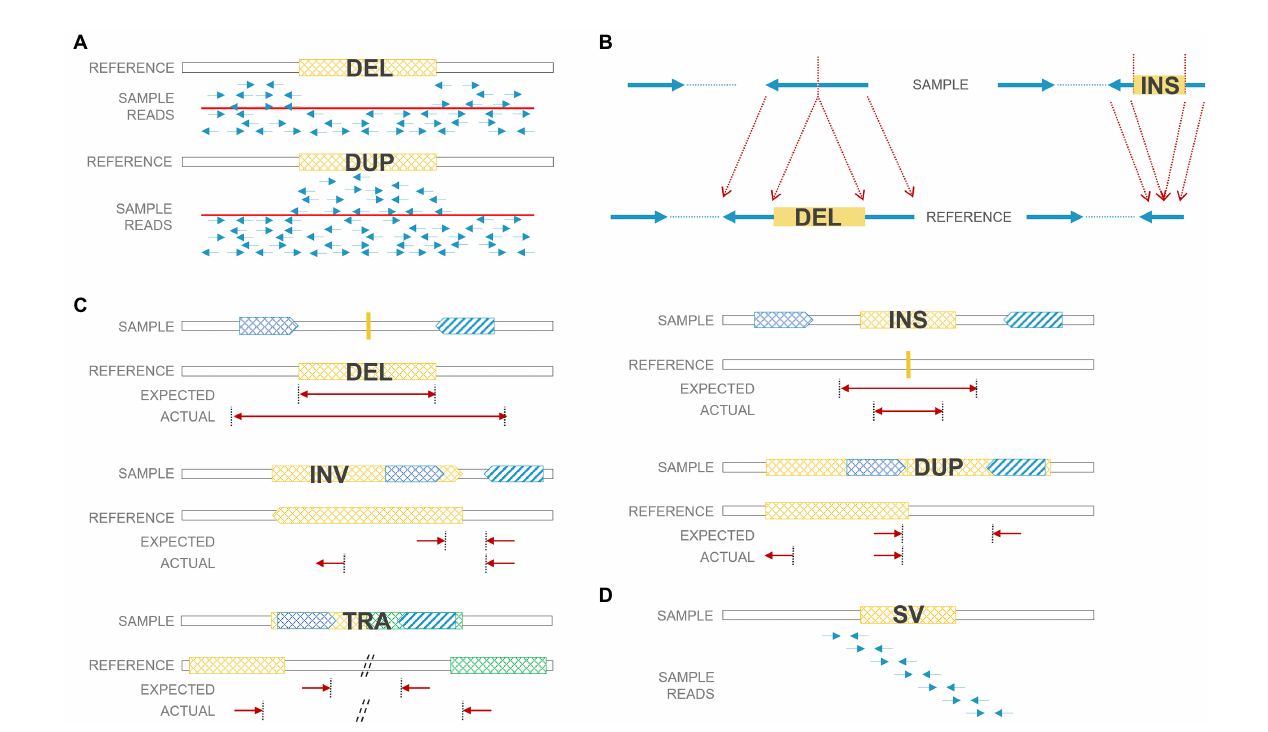
FIGURE 2 SV detection strategies using short reads. (A) Read-depth-based method: deleted regions have low coverage; duplicated regions have high coverage. (B) Split-read-based method: deleted/inserted regions can be detected by split reads. (C) Paired-end-read based method: paired reads from deletions/ duplications/insertions/inversions/translocations have unexpected insert size or orientation. (D) De nova sequence assembly. DEL: deletion; DUP: duplication; INS: insertion; INV: inversion; TRA: